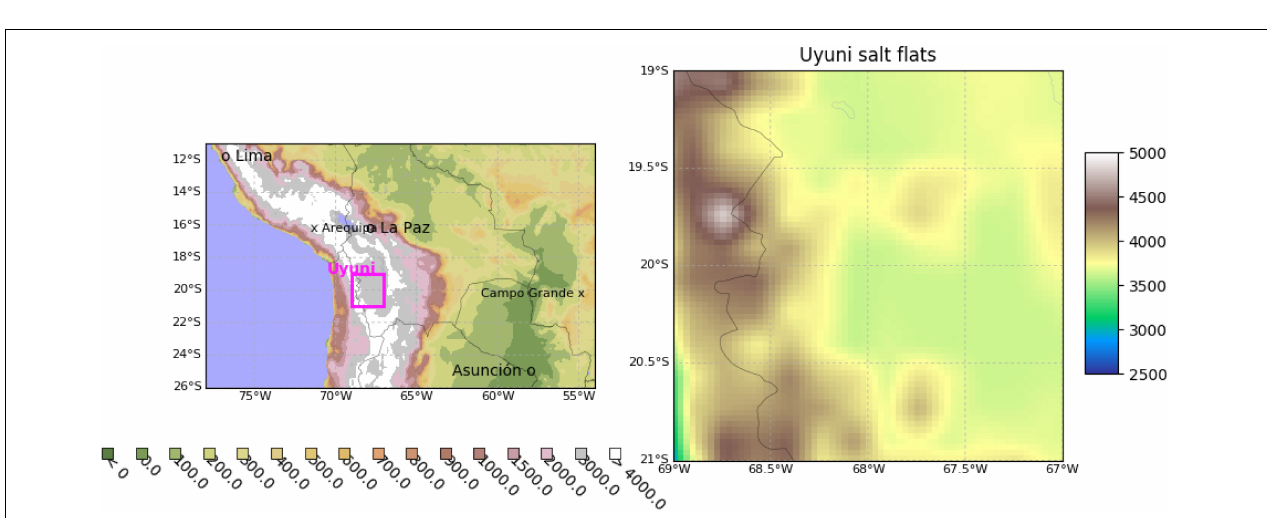
FIGURE 7 | Ensemble mean projected changes of (A) air surface temperature (in ◦ C) and (B) precipitation (in mm/day) in South America. Change is estimated as the difference between the RCP8.5 projection by the end of the 21st century (2071–2100) and the historical simulation by the end of the 20th century (1971–2000). Ensemble mean is obtained considering 48 CMIP5 models. Dots indicate an agreement in the sign of the projected change among 80% or more of the models.